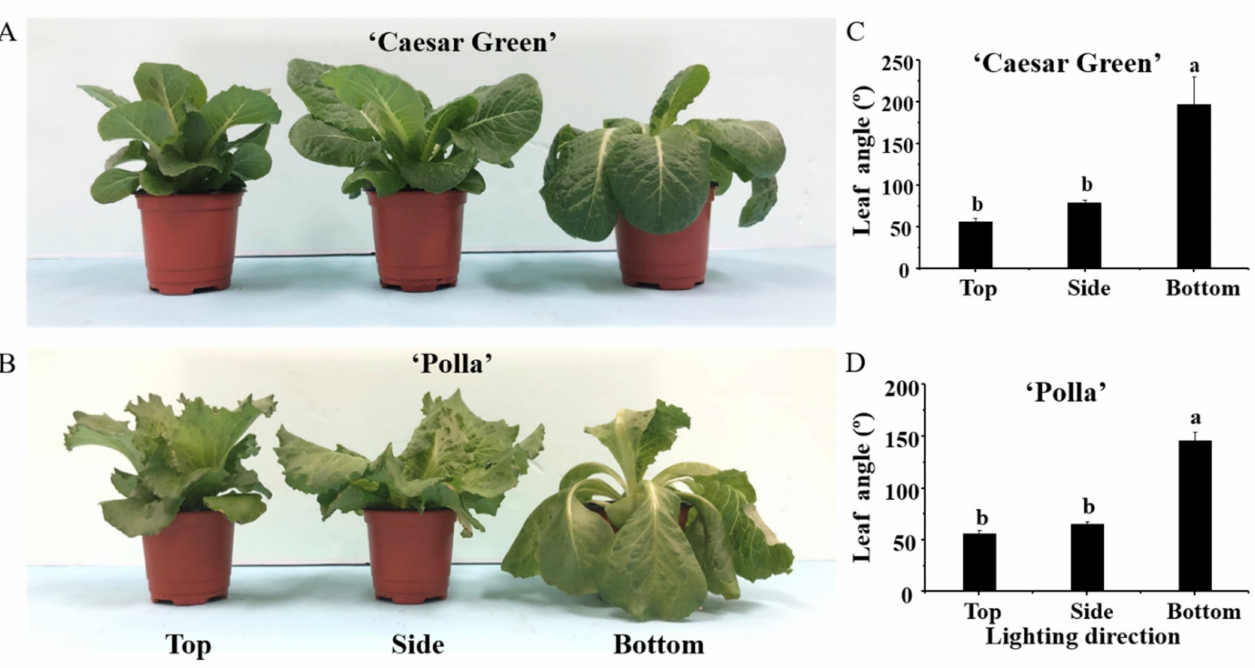
Figure 1. Morphology ( A , B ) and leaf angles ( C , D ) of lettuce Caesar Green and Polla as affected by the lighting direction after 30 days of cultivation. Vertical bars indicate the means ± stand error ( n = 3). Different small letters indicate the significant separation within treatments by the Duncan’s multiple range test at p ≤